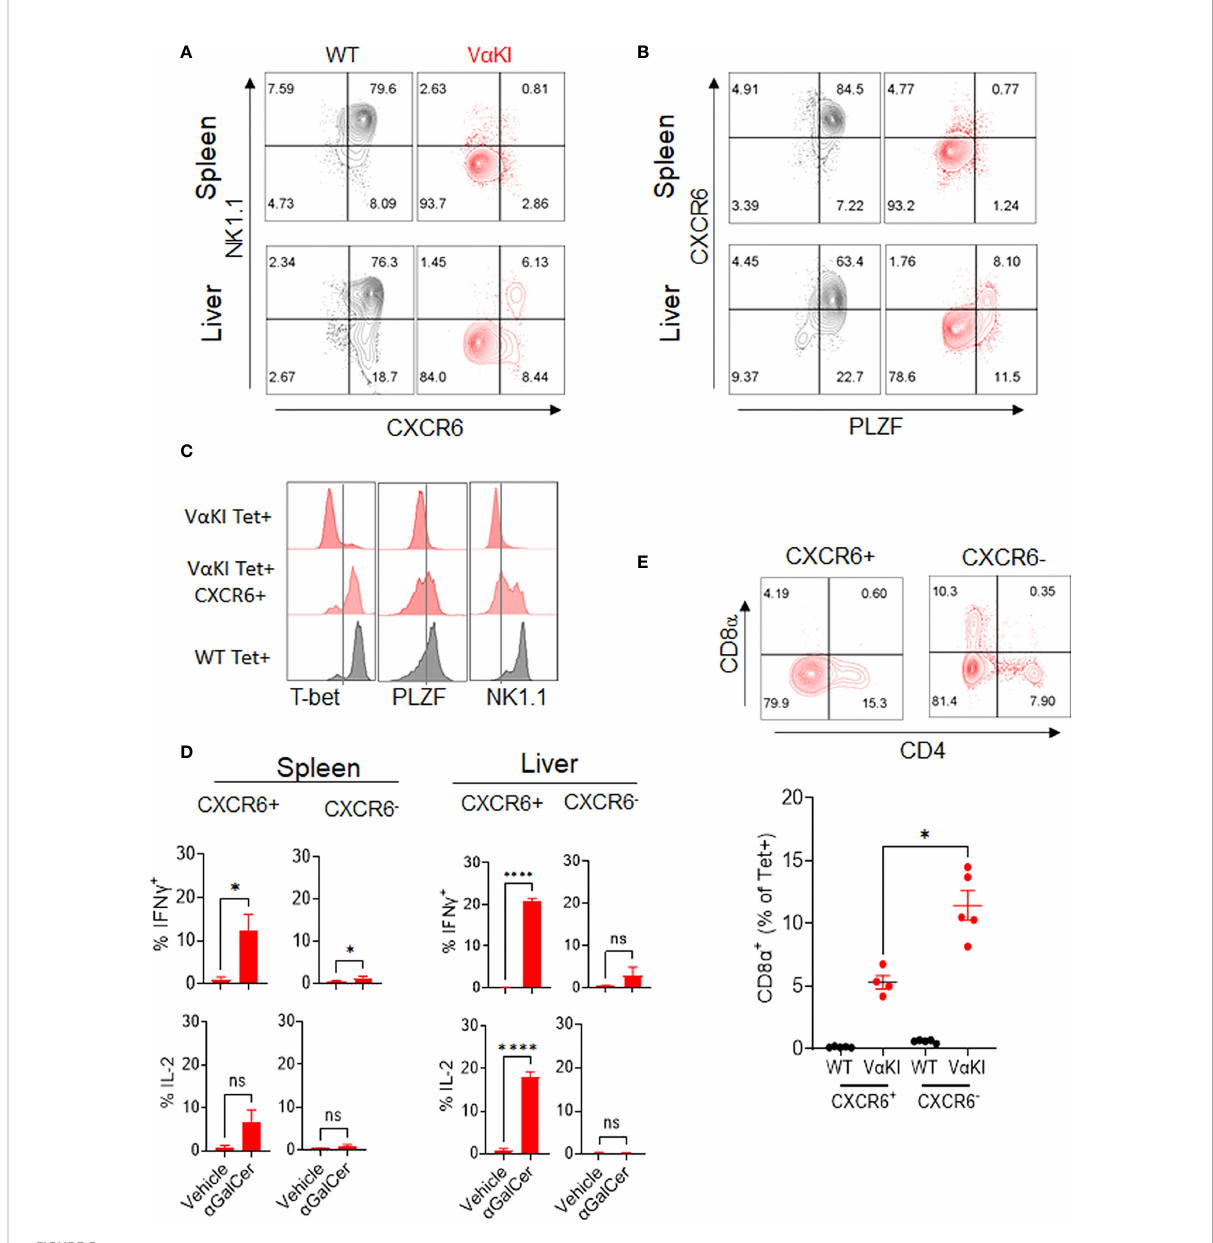
FIGURE 5 Identi fi cation of functional iNKT cells in V a KI mice based on CXCR6 expression. (A) NK1.1 and CXCR6 protein expression, and (B) PLZF and CXCR6 expression on CD1d tetramer+ cells in spleen and liver of WT (C57BL/6) and V a KI mice. Numbers in quadrants show percentage of total tetramer+ cells. (C) FACS analysis of intracellular T-bet and PLZF and cell surface NK1.1 on total or CXCR6+ CD1d tetramer+ cells from spleens of V a KI mice. Staining of total CD1d tetramer+ cells from WT mice is shown for comparison. (D) FACS analysis of staining for intracellular IFN ɣ and IL-2 in CD1d-Tet+ cells from spleen or liver harvested 2 hours after i.v. injection of 4 nanomoles of a GalCer (glycolipid 7DW8-5) or inert vehicle. Staining with mAb to CXCR6 was included to separately analyze the CXCR6+ and CXCR6 negative subsets of tetramer binding cells. (E) FACS analysis of CD4 and CD8 a expression in splenic CD1d-tetramer binding cells, gated on CXCR6 positive and negative subsets. Representative plots for one individual mouse among fi ve analyzed are shown, and the graph below shows results for all animals with mean ± 1SE. ns, not signi fi cant *P < 0.05, ****P < 0.0001 (Mann-Whitney